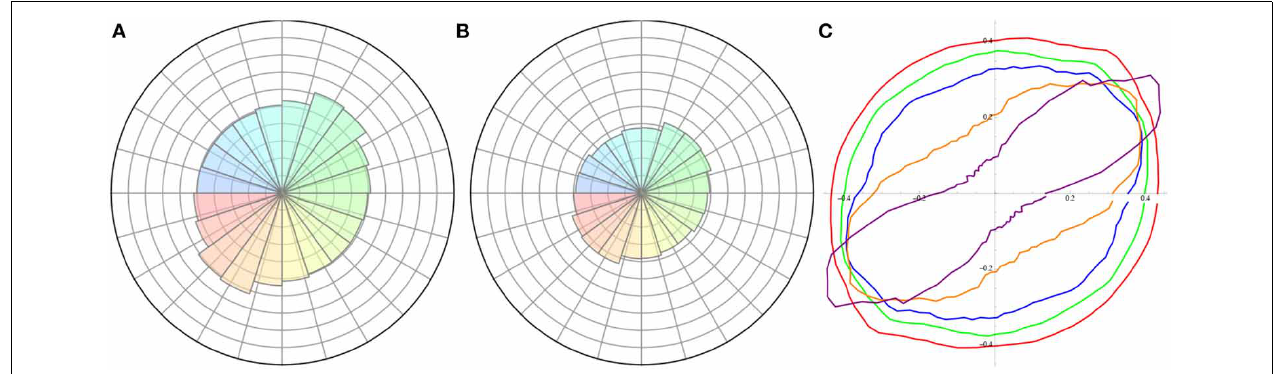
FIGURE 8 | Pair correlation function of the post-rupture granite image (Figure 1B). (A) Polar representation of the pair correlation function. Analysis radius is 8 pixels ; polar angle takes 20 uniformly distributed values between 0 and 2 π . (B) Same with